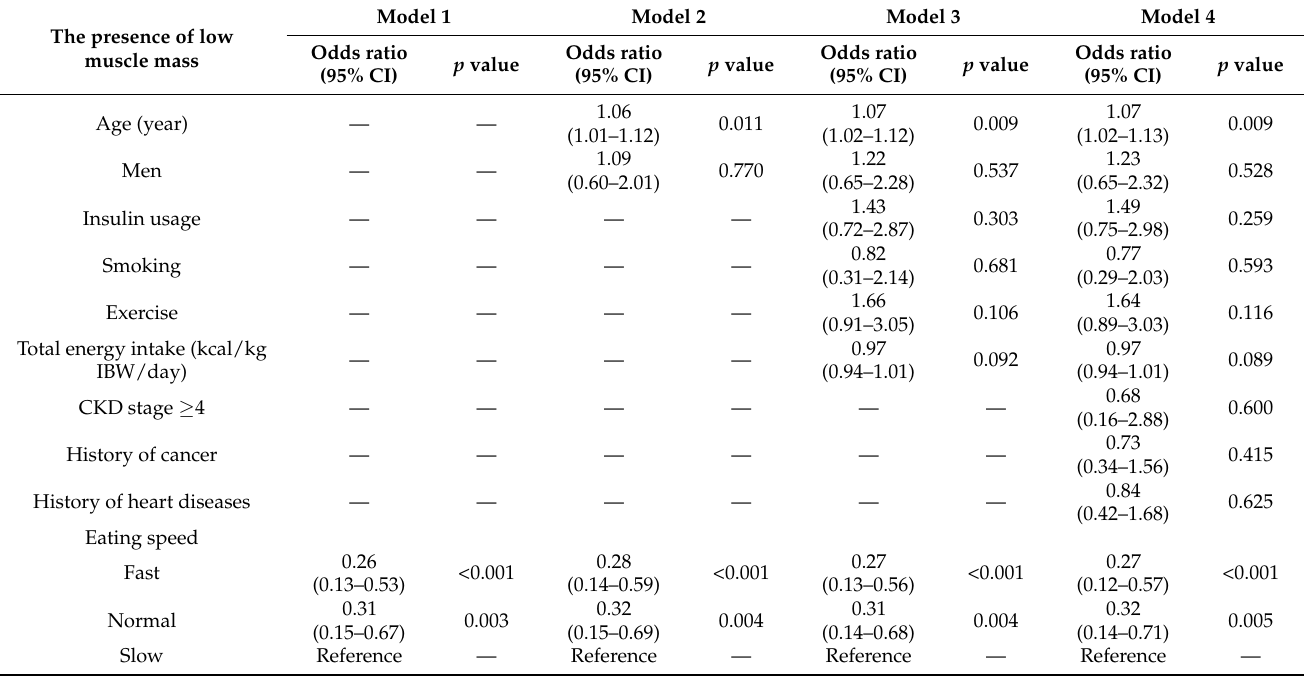
Table 2. Relationship between eating speed and the presence of sarcopenia.